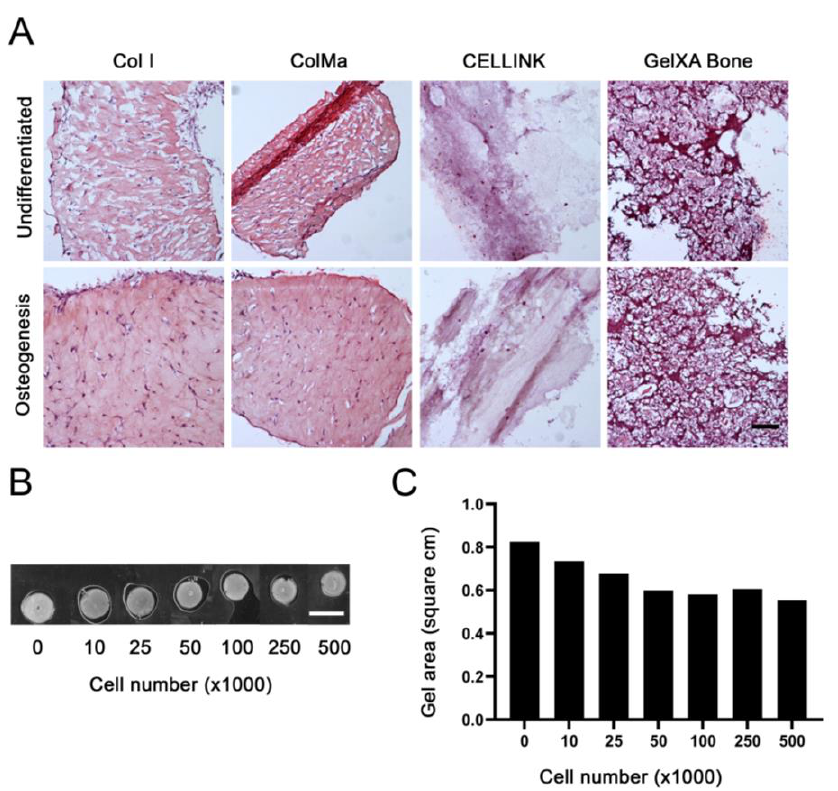
Figure 2. Gel selection and cell number optimization. ( A ) HE stainings from one BMSC donor cultured in 3D with different biogels: type I collagen (Col I), methacrylated type I collagen (ColMa), alginate and nanocellulose-based bioink (CELLINK) and a methacrylated gelatin and alginate-based gel supplemented with HA-TCP (GelXA Bone). The gels were cultured with 2 × 10 5 BMSCs/gel for 5 weeks in control or osteogenic media. Scale bar = 100 μm. ( B ) Six days in vitro Col I gel cast at 200 μL to yield 0.8 cm 2 constructs with various cell numbers per gel to visualize gel shrinkage. Scale bar = 1 cm ( C ) Quantification of scanned gel size displayed in B processed with Image J Software.